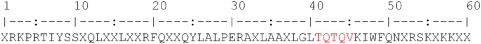
Canonical DLX sequence.The DLX specific TQTQV motif is highlighted in red.